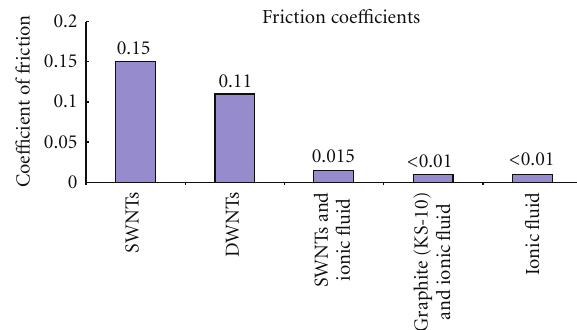
Figure 1: Friction coe ffi cients of di ff erent lubricant systems.